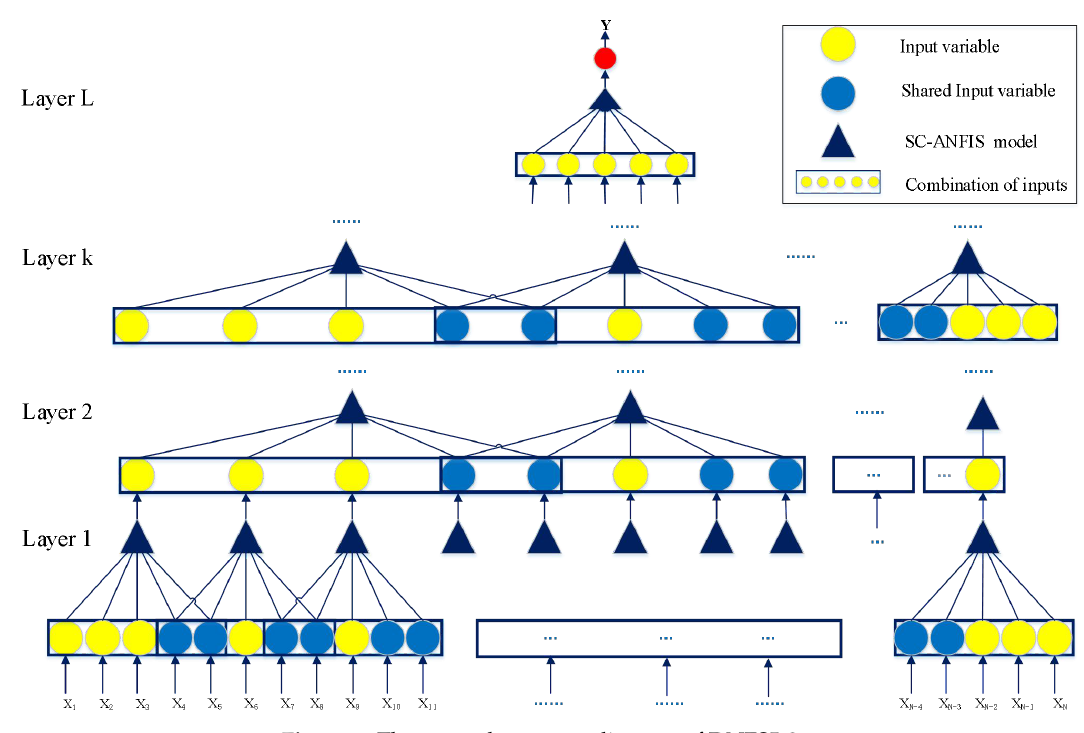
Figure 1. The general structure diagram of